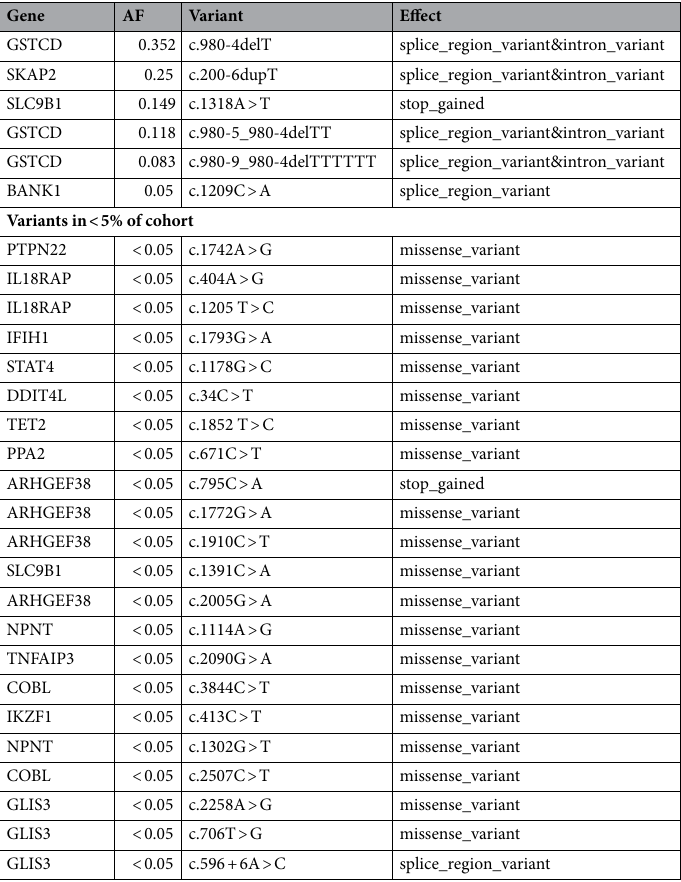
Table 2. Variants observed in genes known to be associated with type 1 diabetes mellitus present in our